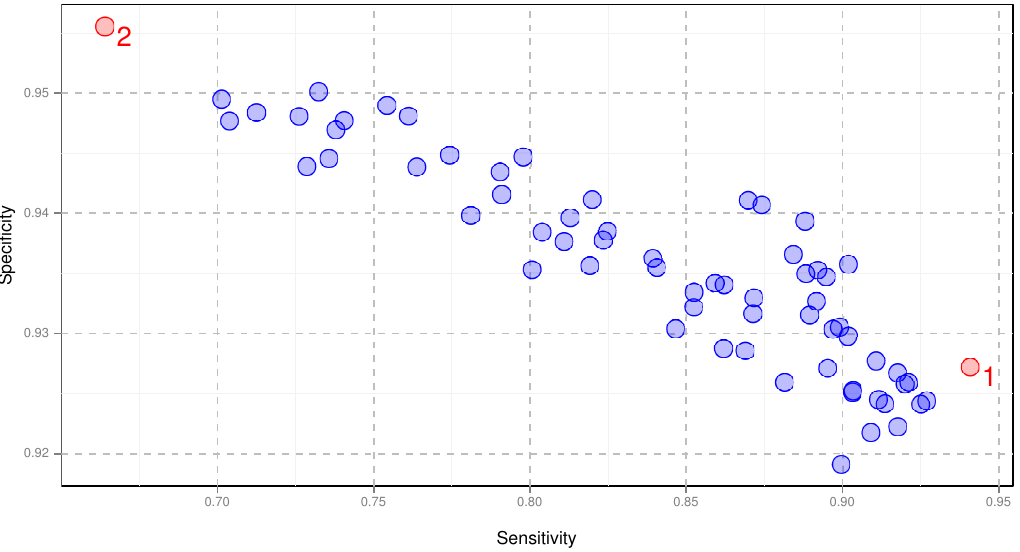
Figure 3. Sensitivity and specificity of amino acid encodings after cross-validation. (1) encoding providing the best sensitivity (AUC = 0.9683, MCC = 0.8677), (2) encoding providing the best specificity (AUC = 0.9338, MCC = 0.6474). These encodings are shown in Tables 2 and 3,